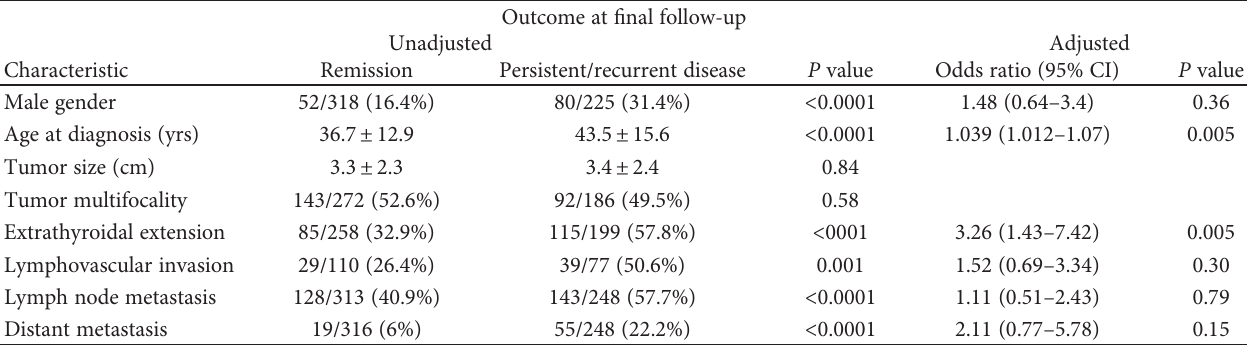
Table 5: Univariate and multivariate analyses of demographic and histopathological predictive factors for the outcome at the last follow-up visit.